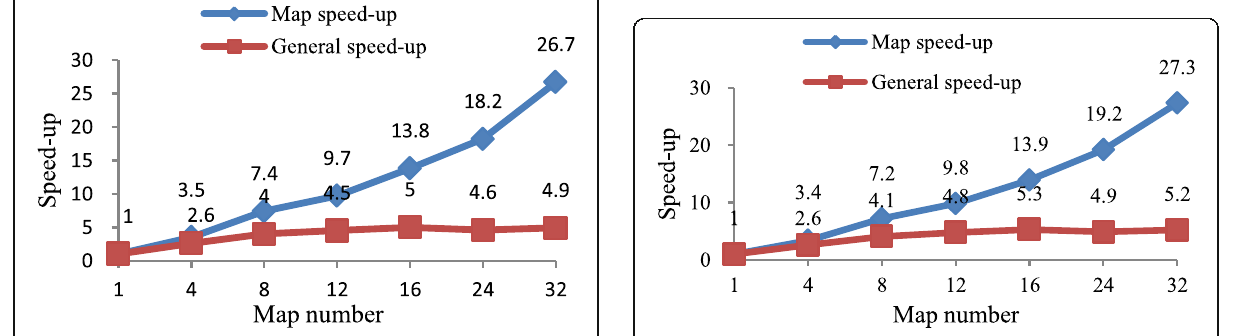
Fig. 7 The speed-up rate of 4 GB on different cores. The figure compares the Map speed-up and General speed-up of a 4-GB file under different cores in parallel